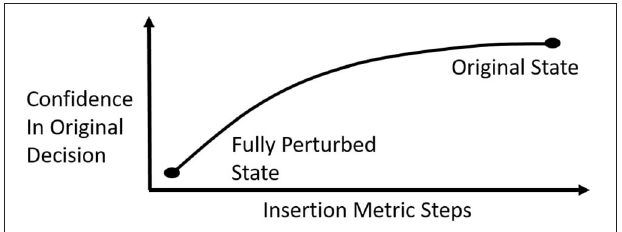
FIGURE 2 | A schematic representation of the insertion metric